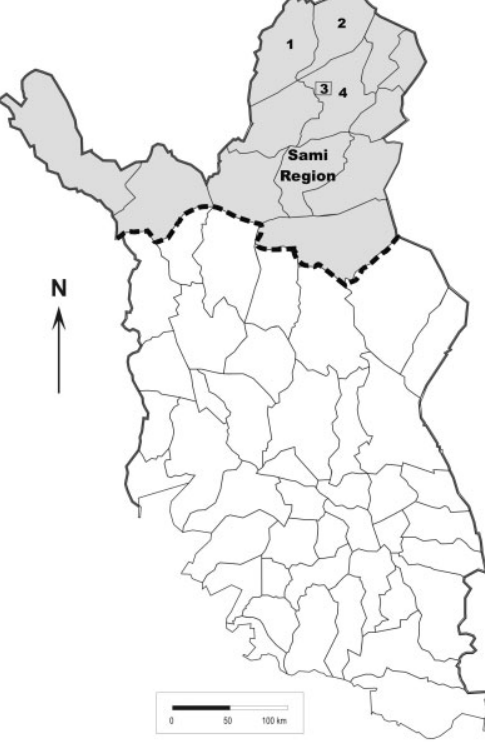
Fig. 1. Reindeer herds studied for the prevalence of gas- trointestinal nematodes in the Sami region. The whole map represents the Finnish Reindeer Husbandry Area. Investigated cooperatives are: 1. Paistunturi, 2. Kaldoaivi, and 4. Muddusjärvi. Area 3 surrounded by a quadrangle identifies the general location of the fenced-in Kutuharju Experimental Reindeer